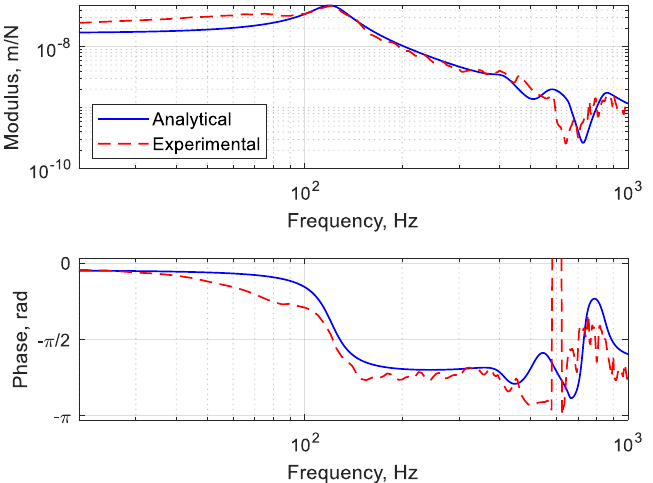
9 of 19 Figure 4. Track direct vertical receptance. The analytical receptance of the analysed track section is compared in Figure 5 with the experimental one in order to verify the accuracy of the analytical model. The experi- mental receptance is obtained by means of a hammer test, in which the rail is excited with